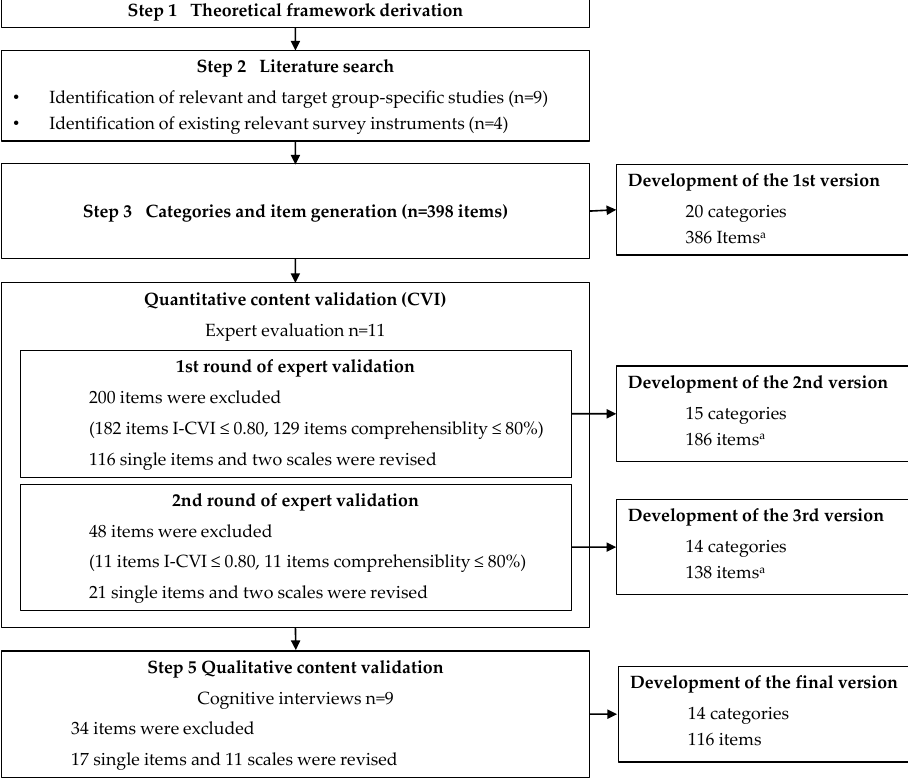
Figure 1. Study approach for developing the instrument.